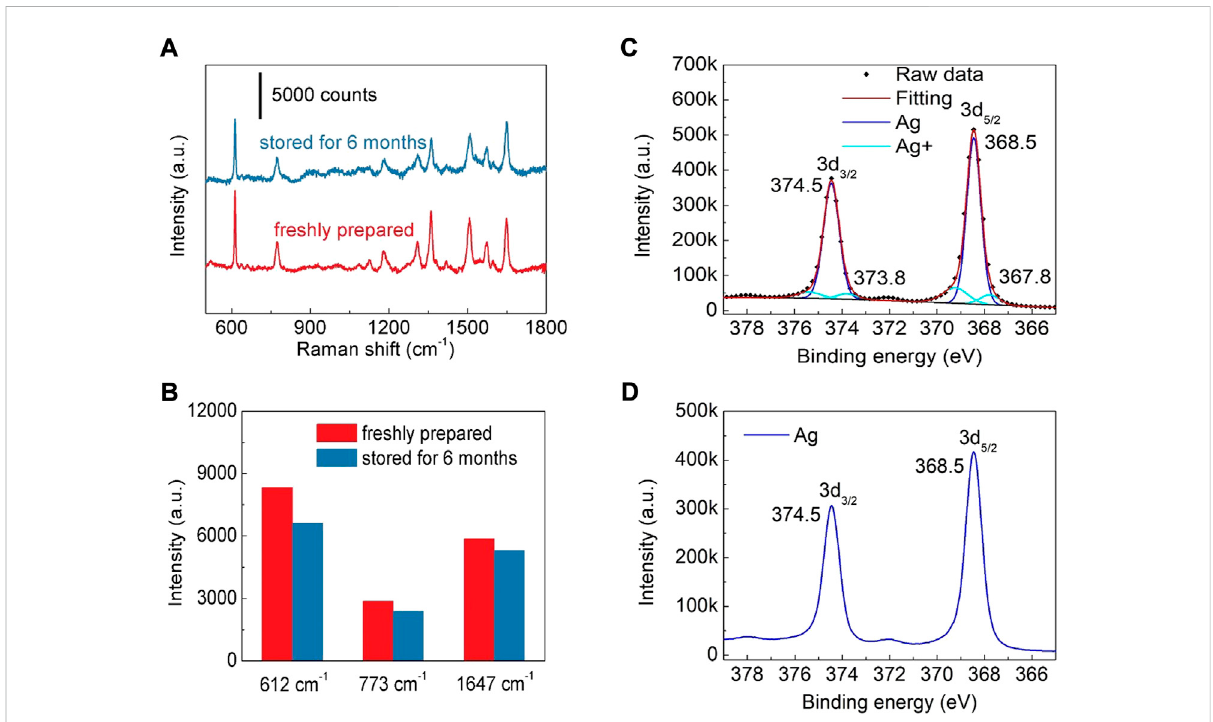
FIGURE 5 (A) SERS spectra of R6G (10 − 7 M) collected from the freshly prepared substrate and the one kept for 6 months (B) The intensity of R6G peaks at 612, 773 and 1,647 cm − 1 . (C) The Ag 3days XPS spectrum of thesubstrate stored for 6 months (D) The Ag3days XPSspectrum ofthefreshlyprepared